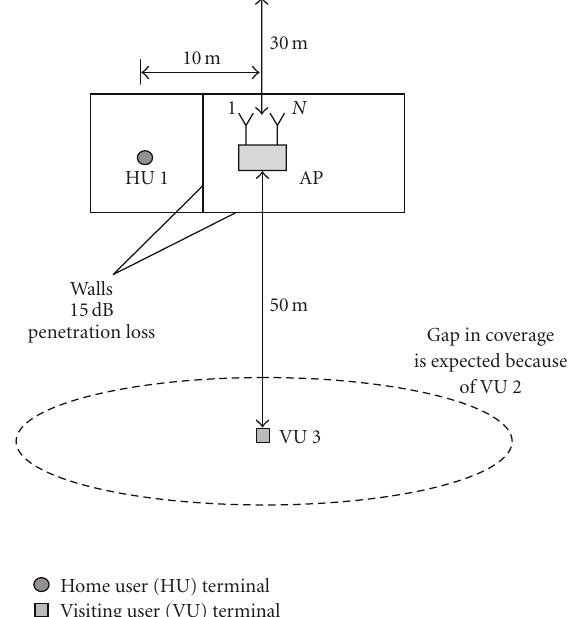
Figure 4: Residential OAN scenario with home and visiting